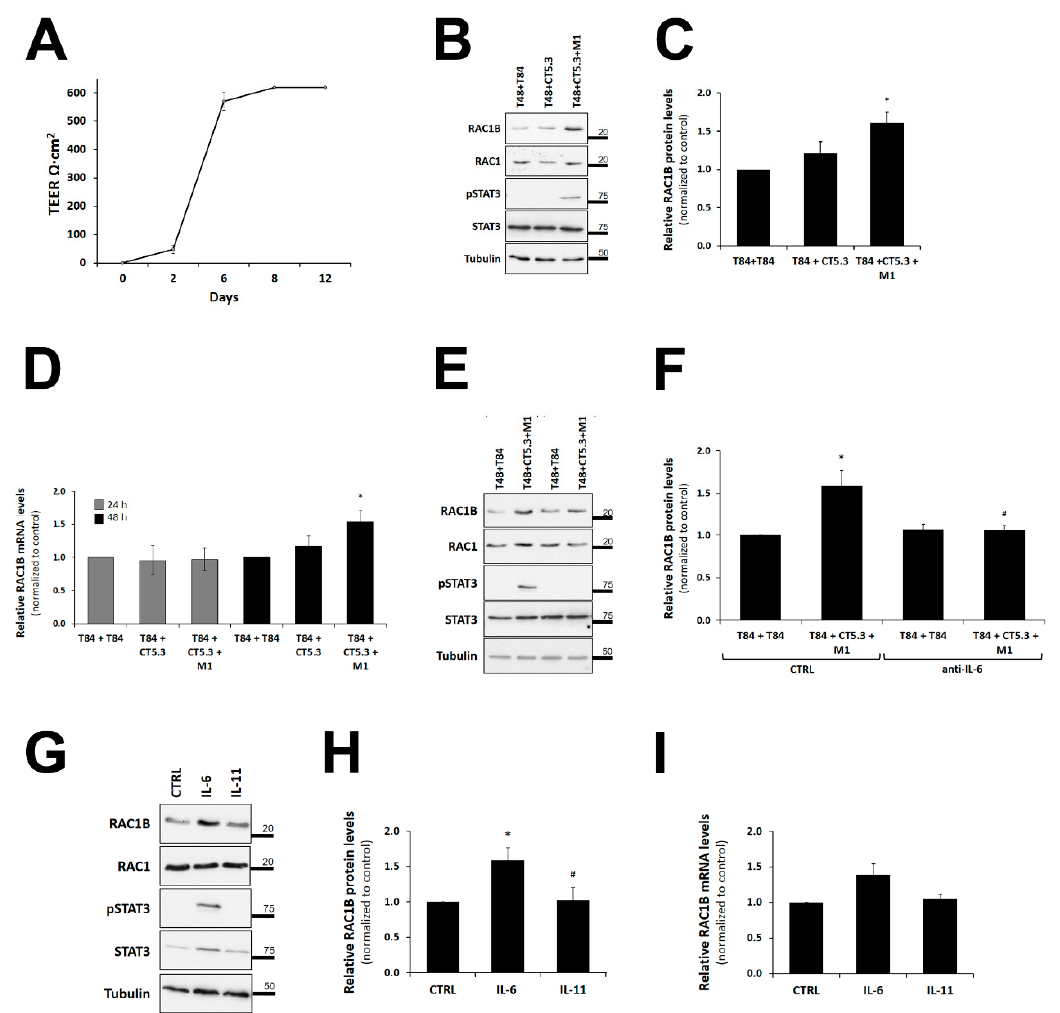
Figure 7. Effect of pro-inflammatory co-culture conditions or of purified IL-6 on RAC1B levels in polarized T84 cells. ( A ) Progress of cell polarization of T84 cells grown on filter inserts was monitored by TEER measurement with a Chopstick Electrode STX2, during up to twelve days. ( B – D ) Effect of co-culture conditions on RAC1B levels. Polarized T84 cells were co-cultured with control T84 or the indicated stromal cells and lysed after 24 h or 48 h of culture. ( B ) Proteins from the whole-cell lysates were analysed by SDS-PAGE and the indicated proteins detected by WB. Migration position of molecular weight markers is indicated in kDa. The control of the assay corresponds to the co-culture of T84 with T84 cells. Corresponding quantification of ( C ) RAC1B protein and ( D ) transcript levels by qRT-PCR in T84 cells obtained from at least six independent biological replicate experiments. Band intensities were measured and the RAC1B/RAC1 ratios calculated as before. Data are shown as fold-change of the RAC1B/RAC1 ratio relative to control and represent mean values ± SEM of 5 independent experiments. Statistical analysis was carried out with a one-way ANOVA test (F = 5.49, p = 0.0113 for ( C ) and F = 4.82, p = 0.0219 for ( D )) followed by Tukey’s post hoc tests; * significantly different from the corresponding control (T84 + T84) with p < 0.01 in ( C ) or p < 0.05 in ( D ). ( E , F ) Effect of neutralizing antibodies against IL-6 on RAC1B and phospho-STAT3 protein levels. Polarized T84 cells were co-cultured with the indicated control or with CT5.3 and M1 macrophages, in the presence of 500 ng/mL of neutralizing antibody against human-IL-6. Graphic shows the fold change in RAC1B protein relative to control and represent mean values ± SEM of at least 5 independent experiments. Statistical analysis was carried out with a one-way ANOVA test (F = 9.62, p = 0.0003), followed by Tukey’s post hoc tests; * or # significantly different with p < 0.01 from the corresponding controls (T84 + T84) or (T48 + CT5.3 + M1), respectively. ( G – I ) RAC1B levels after addition of purified cytokines. Polarized T84 cells were grown on filter inserts and then 10 ng/mL of purified IL-6 or IL-11 (negative control) were added to